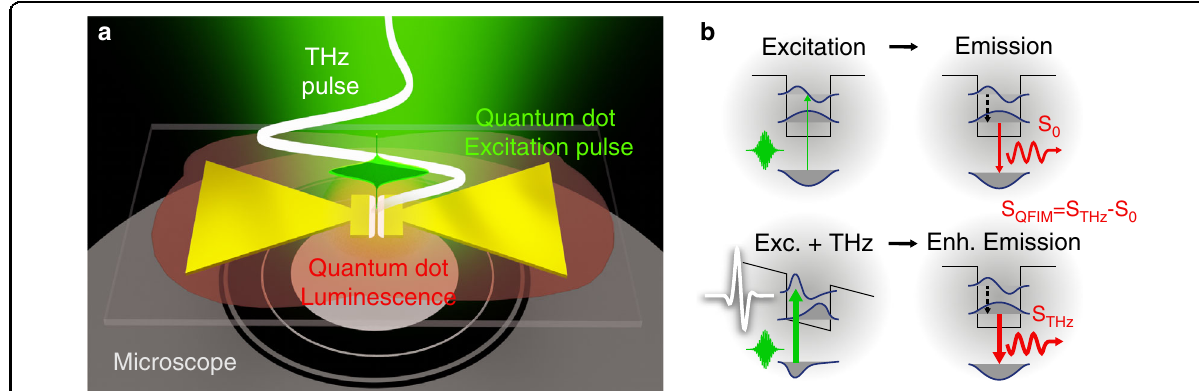
Fig. 1 Quantum-Probe Field Microscopy (QFIM). a Imaging of THz electric near- fi elds in a fl uorescence microscope using quantum dot (QD) luminescence. The absorption of ultrashort visible sampling pulses (green) is modulated via the quantum-con fi ned Stark effect in a layer of nanocrystals (red). b The THz-induced change in the QD band structure can increase the absorption and translates to enhanced luminescence emission, accessible by optical microscopy. The modulated fl uorescence yield S QFIM = S THz − S 0 encodes the instantaneous local electric fi eld and snapshot images resolve the spatio-temporally evolution of the near- fi eld